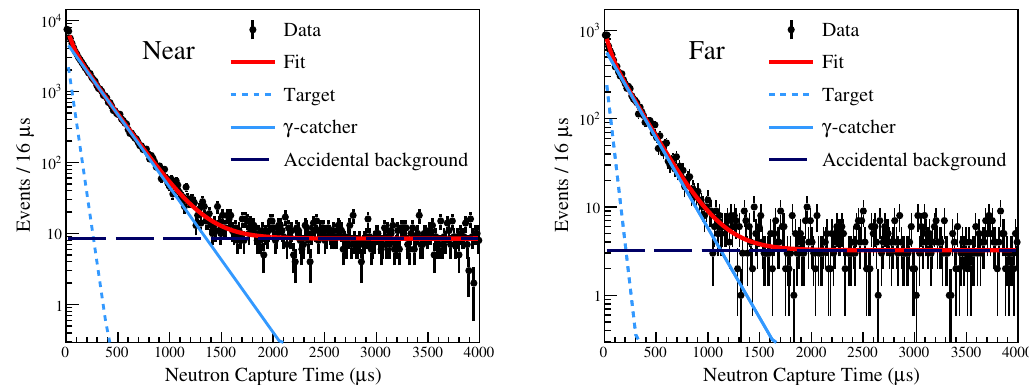
Figure 16 . Time distribution of neutron capture on hydrogen. There are three components of the IBD signals in the target and (cid:13) -catcher regions and the accidental background. The red solid line is the best (cid:12)t to the data. The blue dotted (solid) line represents the (cid:12)tted capture time of the IBD signal in the target ( (cid:13) -catcher) region. The black dashed line corresponds to the capture time of the accidental background.